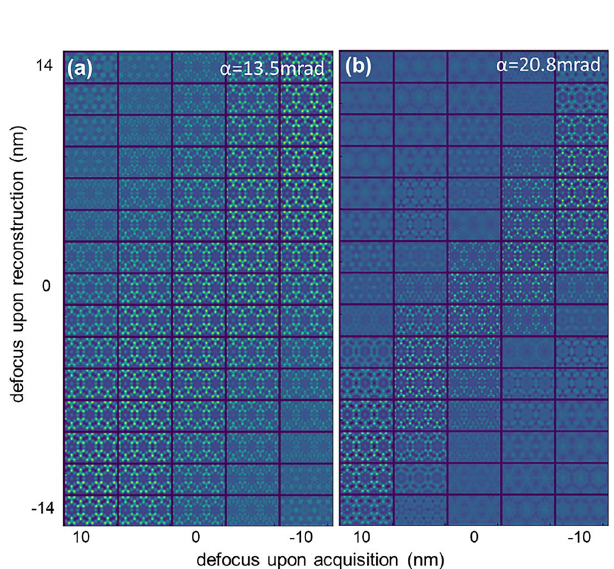
Figure 2. Simulated images of the black rectangle region in Fig. 1a containing six-membered-ring columns with (left) and without (center and right) Cu for the pairs of acquisition (horizontal) and reconstruction (vertical) defocus values with convergence semi-angles of ( a ) 13.5 mrad and ( b ) 20.8 mrad. The simulated area is 2.3 nm × 1.3